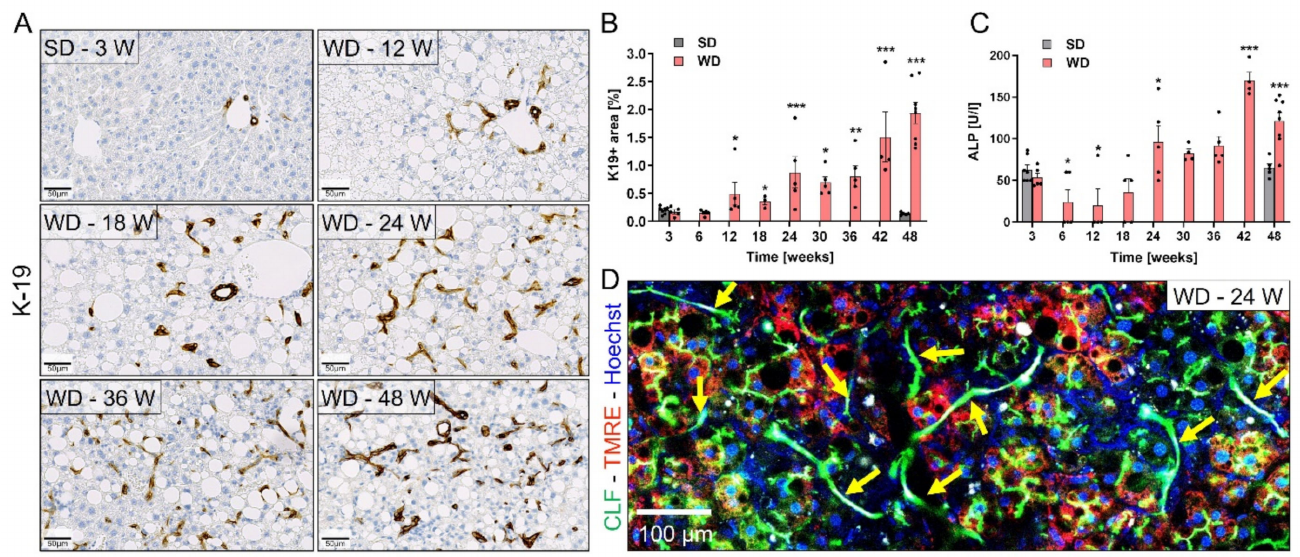
Figure 5. Development of bile-draining ductular reaction during NAFLD progression. ( A ) Immunostaining of the cholan- giocyte marker K19 in liver sections of mice on SD (3 week) or WD over time. ( B ) Quantification of the K19 positive area. ( C ) ALP levels in blood of mice on SD or WD. ( D ) Intravital imaging after intravenous injection of the bile acid analogue CLF (green). Yellow arrows indicate ductular structures. Data in B and C represent mean and standard errors of 3–8 mice per time point. *: p < 0.05; **: p < 0.01; ***: p < 0.001 compared to SD week 3, Dunnett’s multiple comparisons test; data of individual mice are illustrated by dots; SD: standard diet; WD: Western diet; ALP: alkaline phosphatase; CLF: cholyl-lysyl-fluorescein. Scale bars 50 µ m ( A ) and 100 µ m ( D